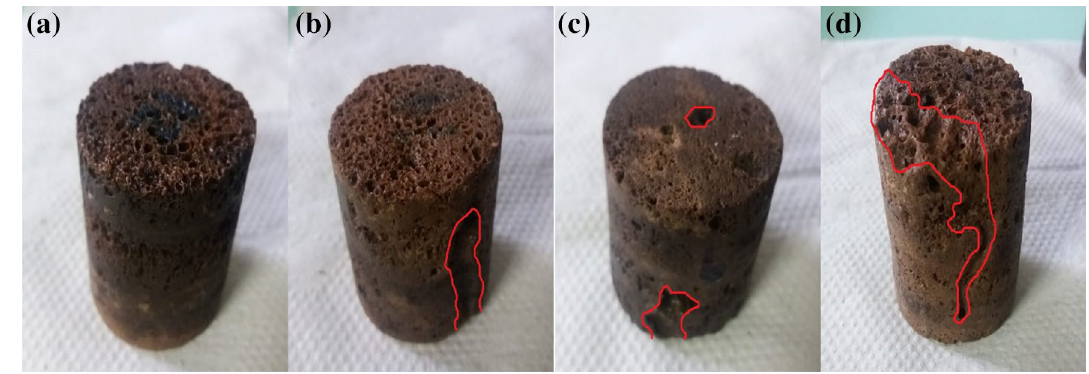
Fig. 8 Plugs after reaction with microemulsion with HCl in concentrations of: a 1.5% (plug I), b 5% (plug II), c 10% (plug III), and d 15% (plug